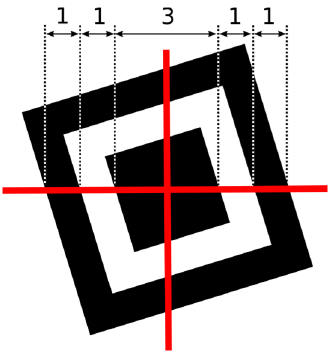
Figure 3. The finder pattern.